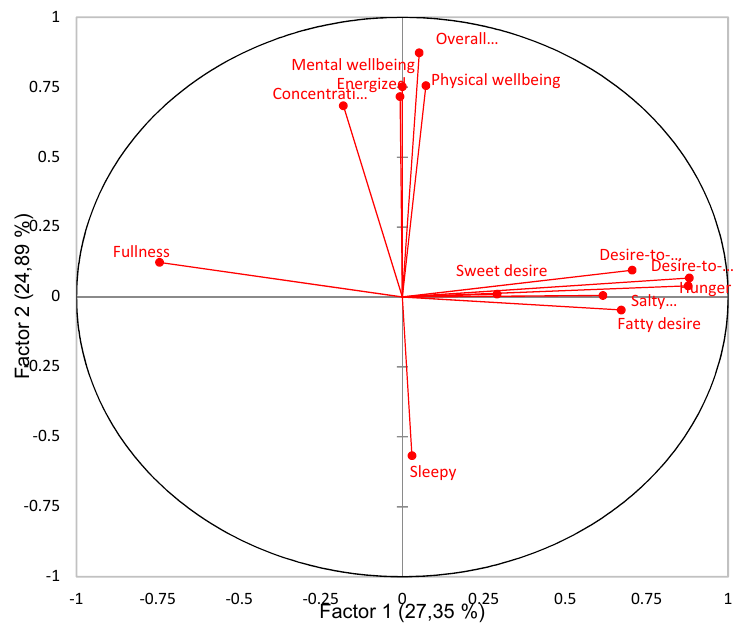
Figure 2. Patterns of correlation for all sensation variables from Principal Component Analysis (PCA)